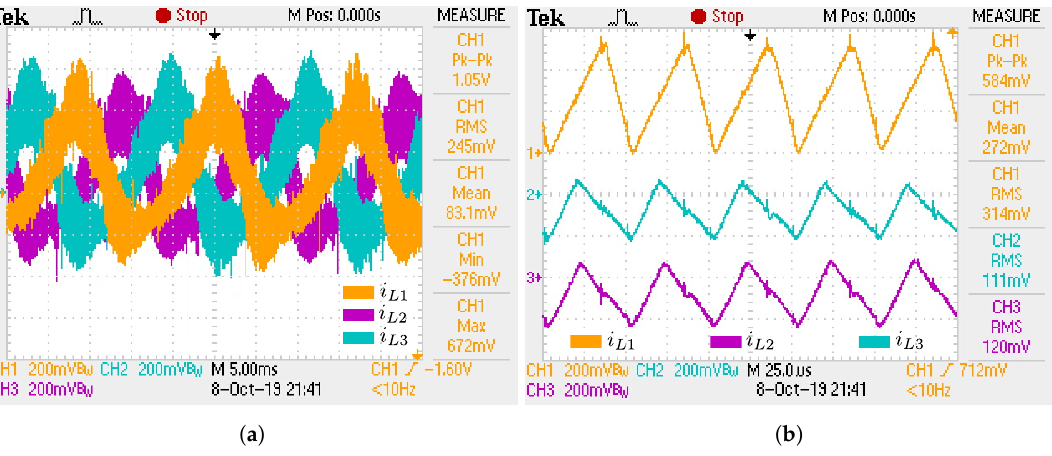
Figure 24. Experimental inductor waveforms for R load case: ( a ) Inductor currents (25A/V); ( b ) Details of inductor currents (25A/V).